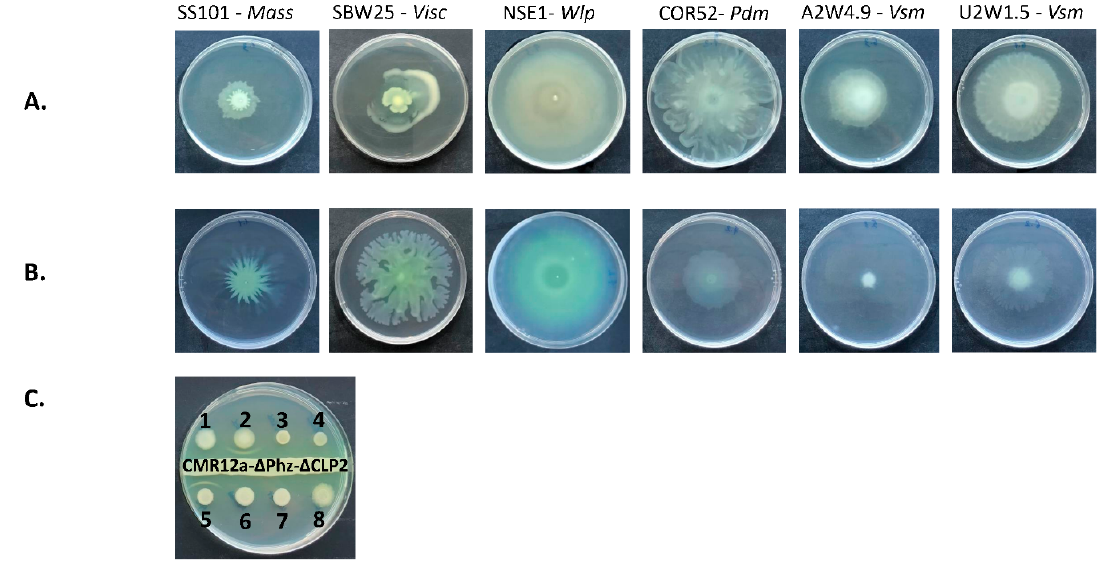
Figure 6. Swarming and white line-in-agar phenotype for Pseudomonas strains producing viscosin-group CLPs. Swarming phenotype of strains grown on ( A ) 0.6% LB medium and ( B ) 0.6% Standard Succinate Medium (SSM). ( C ) White line-in-agar test conducted for Viscosin-group CLP producers in interaction with sessilin producer, Pseudomonas sp. CMR12a- Δ Phz- Δ CLP2. Strains are labelled 1–8: (1) Pseudomonas sp. COR52 (pseudodesmin), (2 ) Pseudomonas sp. NSE1 (WLIP), (3) P. lactis SS101